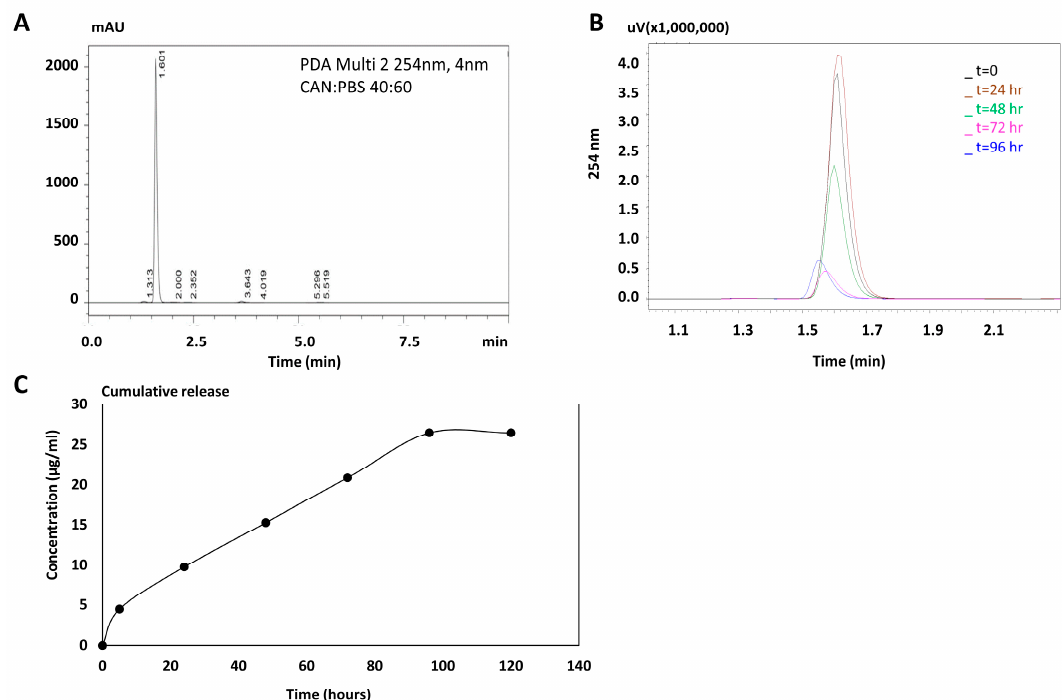
Figure 1. Stability of carbenoxolone and release from poly(lactic-co-glycolic acid) (PLGA) particles using HPLC. ( A ) HPLC detection of carbenoxolone in its free form; ( B ) evaluation of carbenoxolone in an aqueous solution over 96 h; and ( C ) a cumulative release of carbenoxolone from PLGA particles over 96 h.